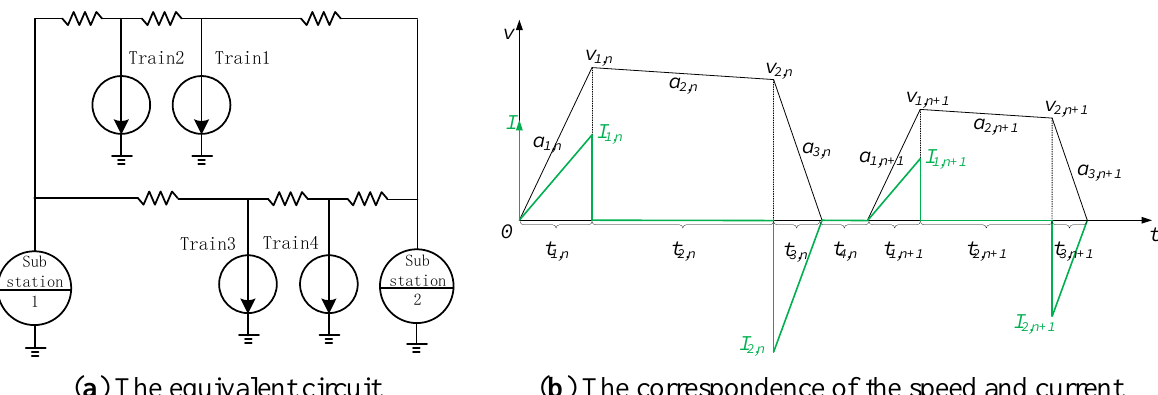
Figure 10. Circuit model of the metro